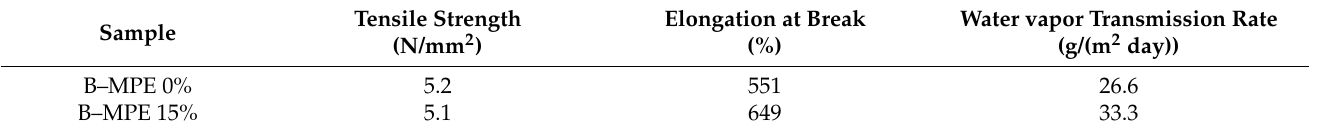
Table 3. Physical properties of Bioelastomer–MPE 0% (control, PMDS) and Bioelastomer–MPE 15%.